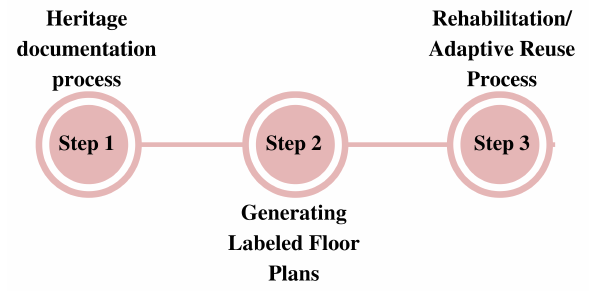
Figure 6. Flowchart representing the steps in the proposed